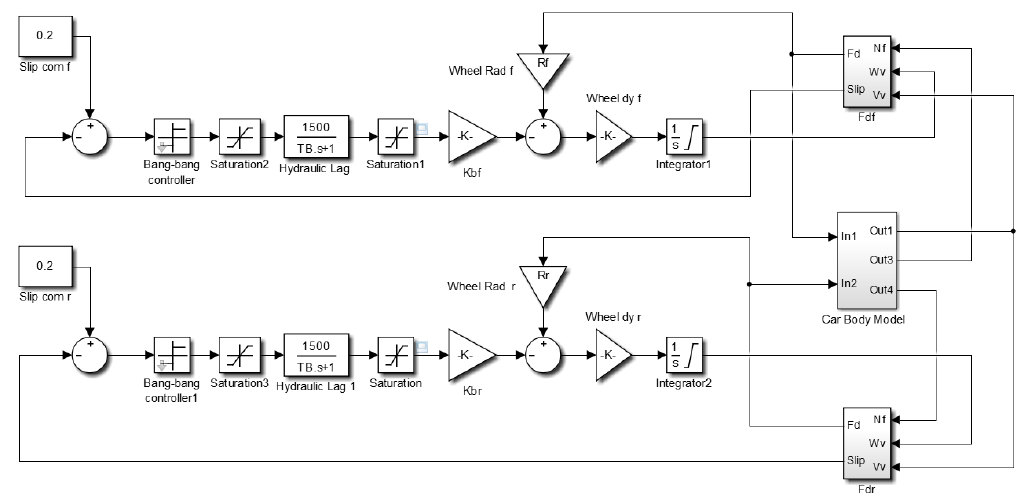
Figure 17. Motorcycle ABS simulation model with an EHB.